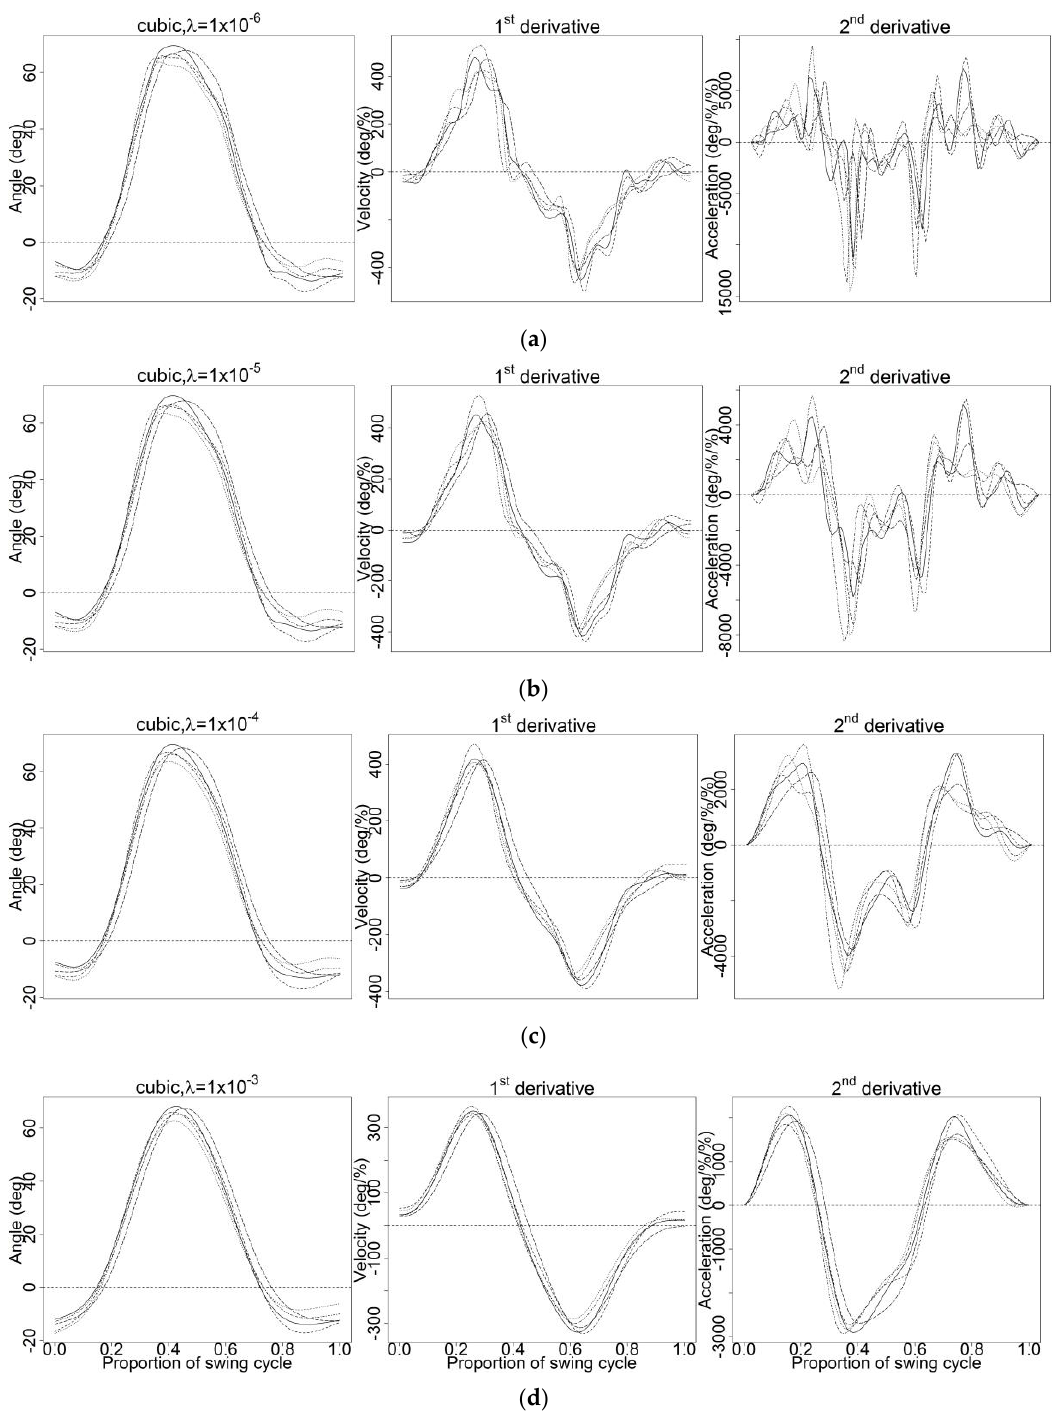
Figure A3. Smoothing using cubic spline basis with various values of λ : ( a ) 1 × 10 − 6 , ( b ) 1 × 10 − 5 , ( c ) 1 × 10 − 4 , and ( d ) 1 × 10 − 3